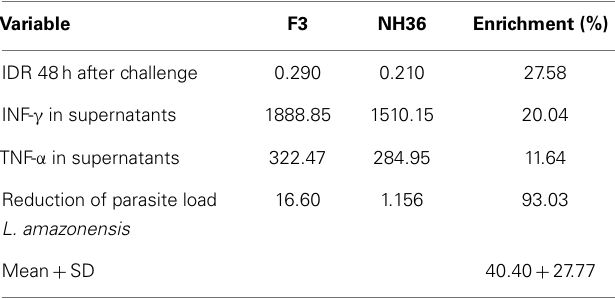
Table 1 | Superiority of the F3 peptide domains over the NH36 vaccine in prophylaxis against L. amazonensis infection